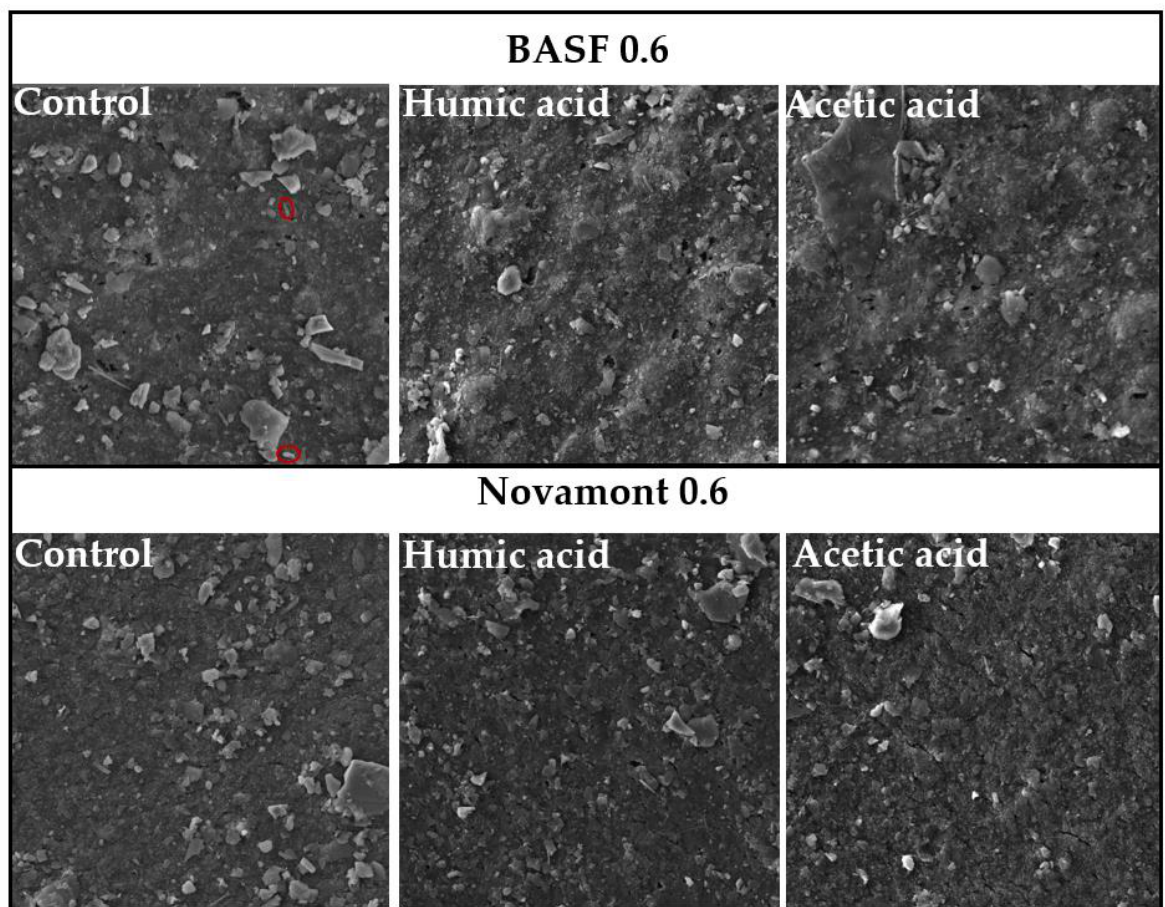
Figure 2. Scanning electron microscopy (SEM) images of BASF 0.6 and Novamont 0.6 mulch samples before surface application (control), and 2 weeks after application of humic and acetic acids. SEM images were collected at a constant 50 µ m field-of-view and constant ~50 µ m pixel size. An example of a microbial cell is circled in green. Table 5. Microbial colonization of plastic soil-biodegradable mulch (BDM) surfaces measured be- fore the application of degradation products, and 2-, 7-, and 14-days following product application, using split-split plot analysis of variance (ANOVA). Scanning electron microscopy (SEM) was per- formed to observe and quantify microbial cells on BDM surfaces before and after product applica- tion (compost tea, humic and acetic acids). Plastic mulch samples (BASF 0.6 and Novamont 0.6) were collected in autumn 2019.